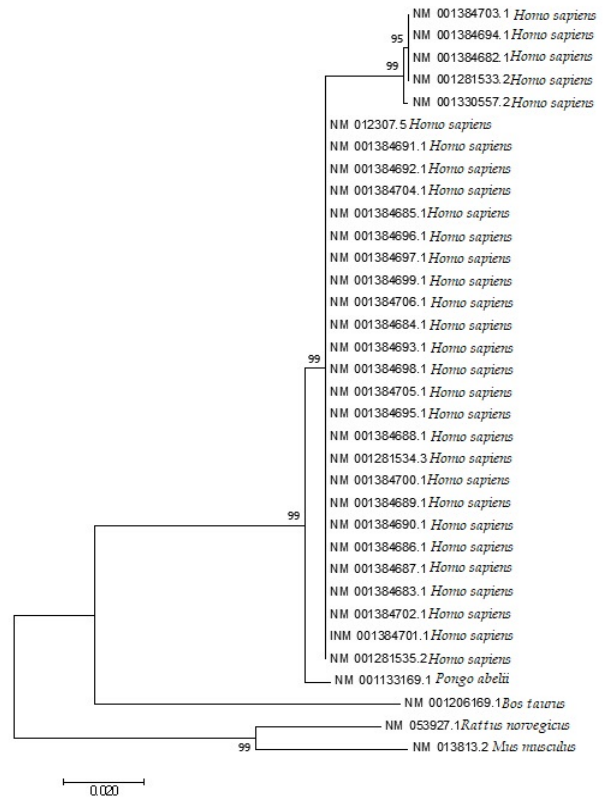
Figure 9. Phylogenetic analysis based on the Kimura two-parameter (K2P) distances of the mRNA coding sequences of the EPB41L3 gene of different mammalian species. The evolutionary analyses were performed in MEGA7, whereas the evolutionary distances were calculated using the Kimura two-parameter method and are presented in the number of base substitutions per site. Table 6. ( a ) Frequency of tRNA genes in the selected mammalian species for the most preferentially used codons in the EPB41L3 gene in Homo sapiens . ( b ) Frequency of tRNA genes in the selected mammalian species for the most preferentially used codons in the EPB41L3 gene in Pongo abelii . ( c ) Frequency of tRNA genes in the selected mammalian species for the most preferentially used codons in the EPB41L3 gene in Rattus norvegicus . ( d ) Frequency of tRNA genes in the selected mammalian species for the most preferentially used codons in the EPB41L3 gene in Mus musculus . ( e ) Frequency of tRNA genes in the selected mammalian species for the most preferentially used codons in the EPB41L3 gene in Bos taurus . The tRNA population corresponding to most favored codon in the EPB41L3 gene is highlighted with red. Homo sapiens (Human) Amino Acid Most Preferred Codons in EPB41L3 Isotypes of tRNA in Human